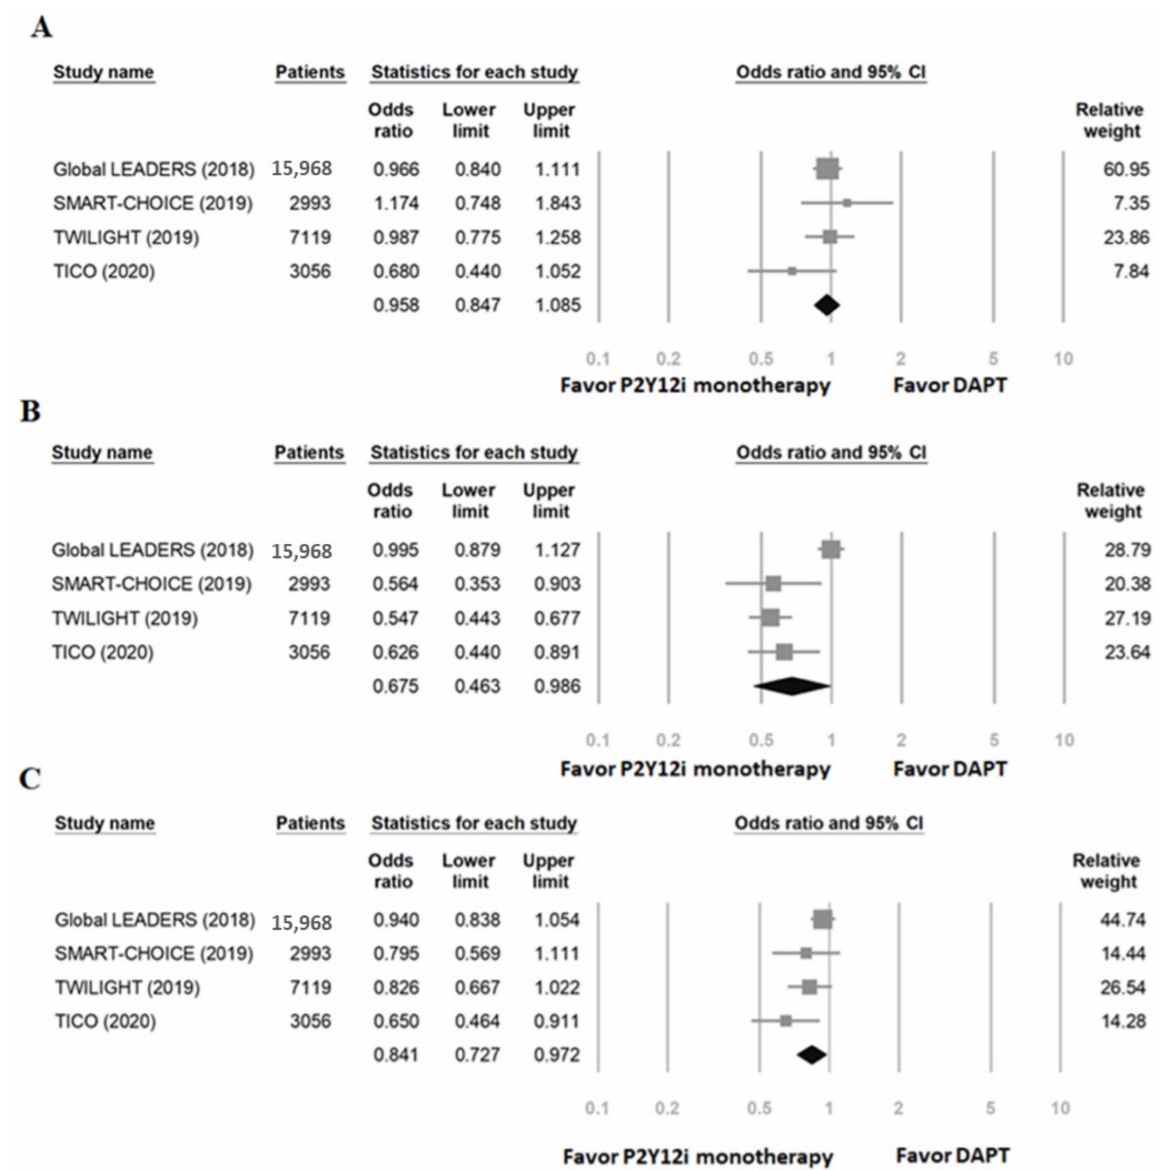
Figure 2. The primary efficacy and safety of P2Y12 inhibitor monotherapy in patients undergoing PCI compared to 12-month DAPT. ( A ) MACCE; ( B ) bleeding events; ( C )